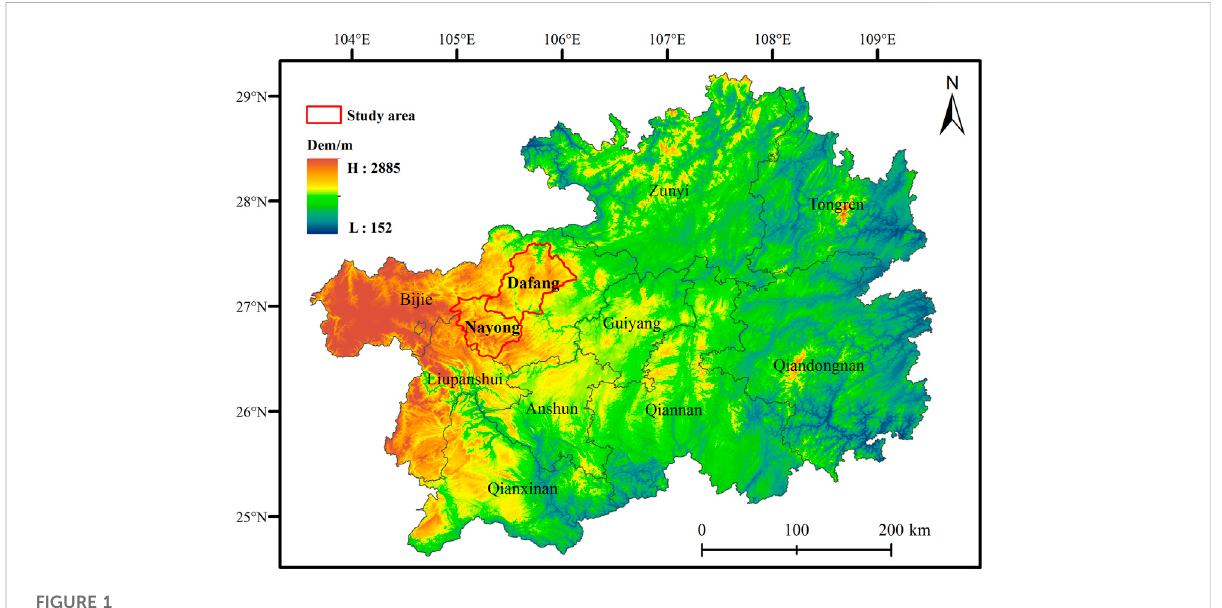
FIGURE 1 Topographic map of